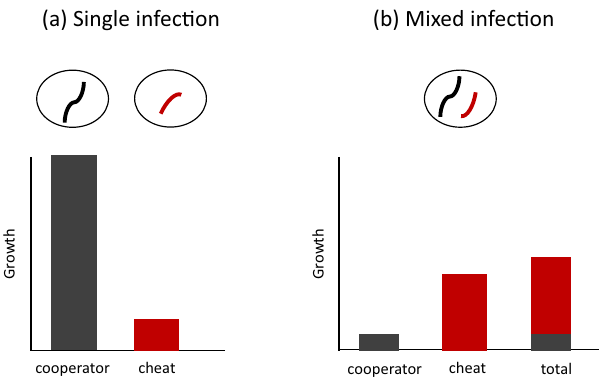
Fig. 3 How to test for a cheat. We illustrate the hypothetical results of an experiment in which a cooperator and a cheat are grown a separately and b together. For two individuals to count as a cheat and cooperator respectively, three conditions must be met: (1) the cooperator must have a higher fi tness than the cheat when each are alone; (2) the cheat must have a higher fi tness than the cooperator when both are mixed; (3) the cooperator must have a lower fi tness in a mixture than it did when it was